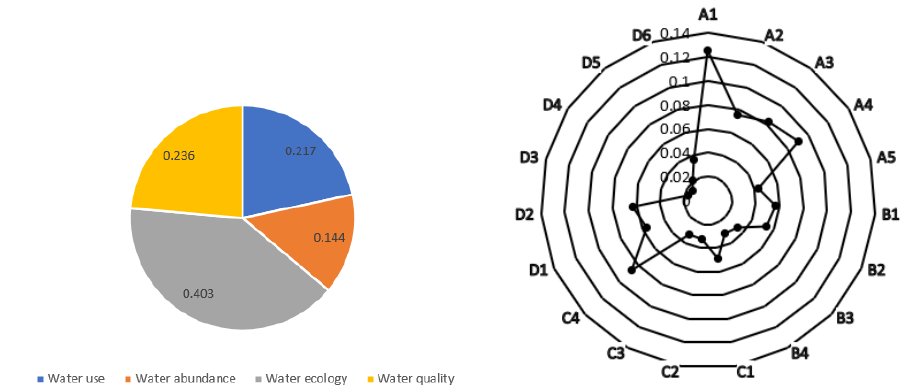
Figure 5. Weight graphs of the criterion and indicator layers.